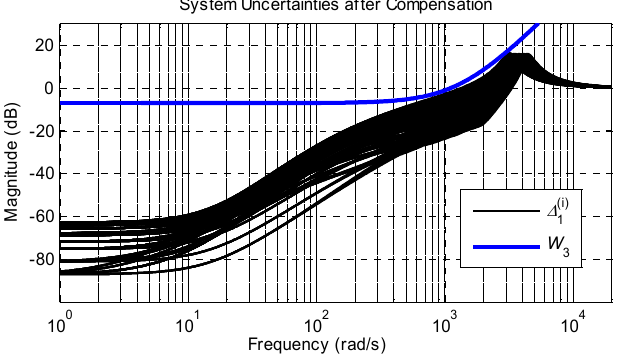
Figure 13. System uncertainties for outer loop design.